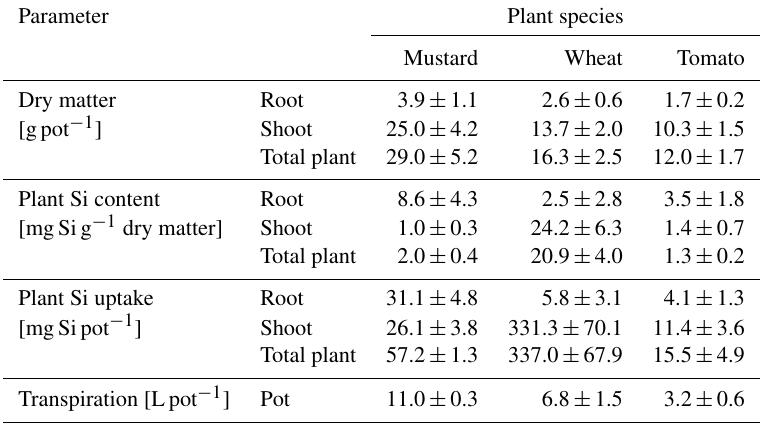
Table 1. Dry matter, plant Si content, plant Si uptake, and water transpiration of mustard, wheat, and tomato after 6 weeks (hydroponic culture; mean ± standard deviation based on three pots with four plants each).